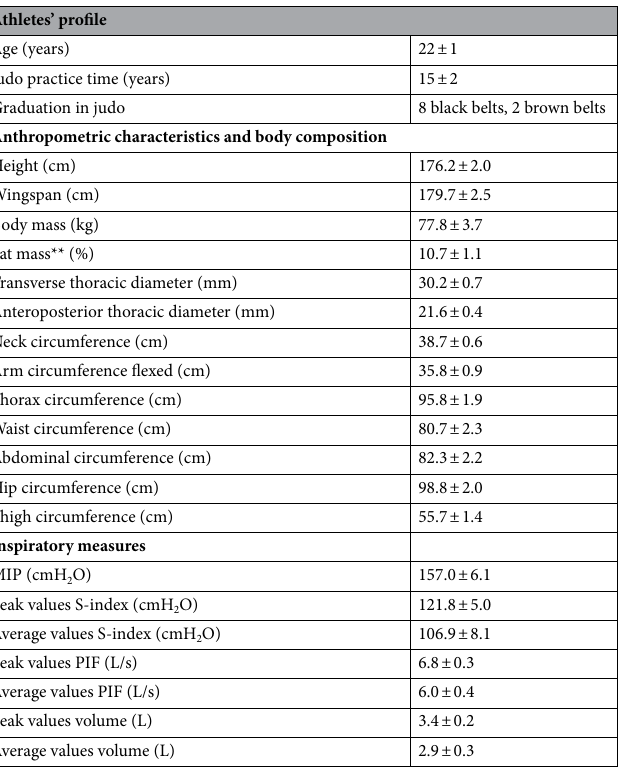
Table 1. Athletes’ profile, anthropometric characteristics and body composition and inspiratory measure of the participants. **7 Skinfolds 36 . Results are expressed as mean values ± SEM. MIP muscle inspiratory pressure, PIF peak inspiratory